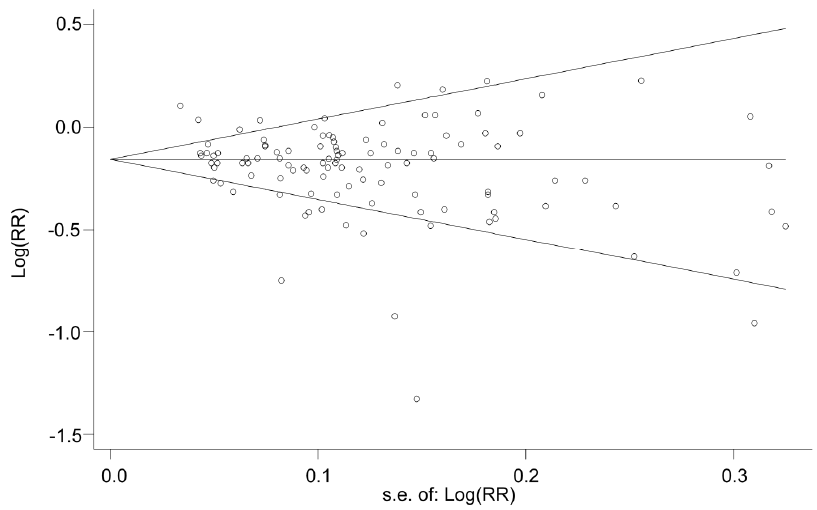
Figure 2. Funnel plot with pseudo 95% confidence limits.